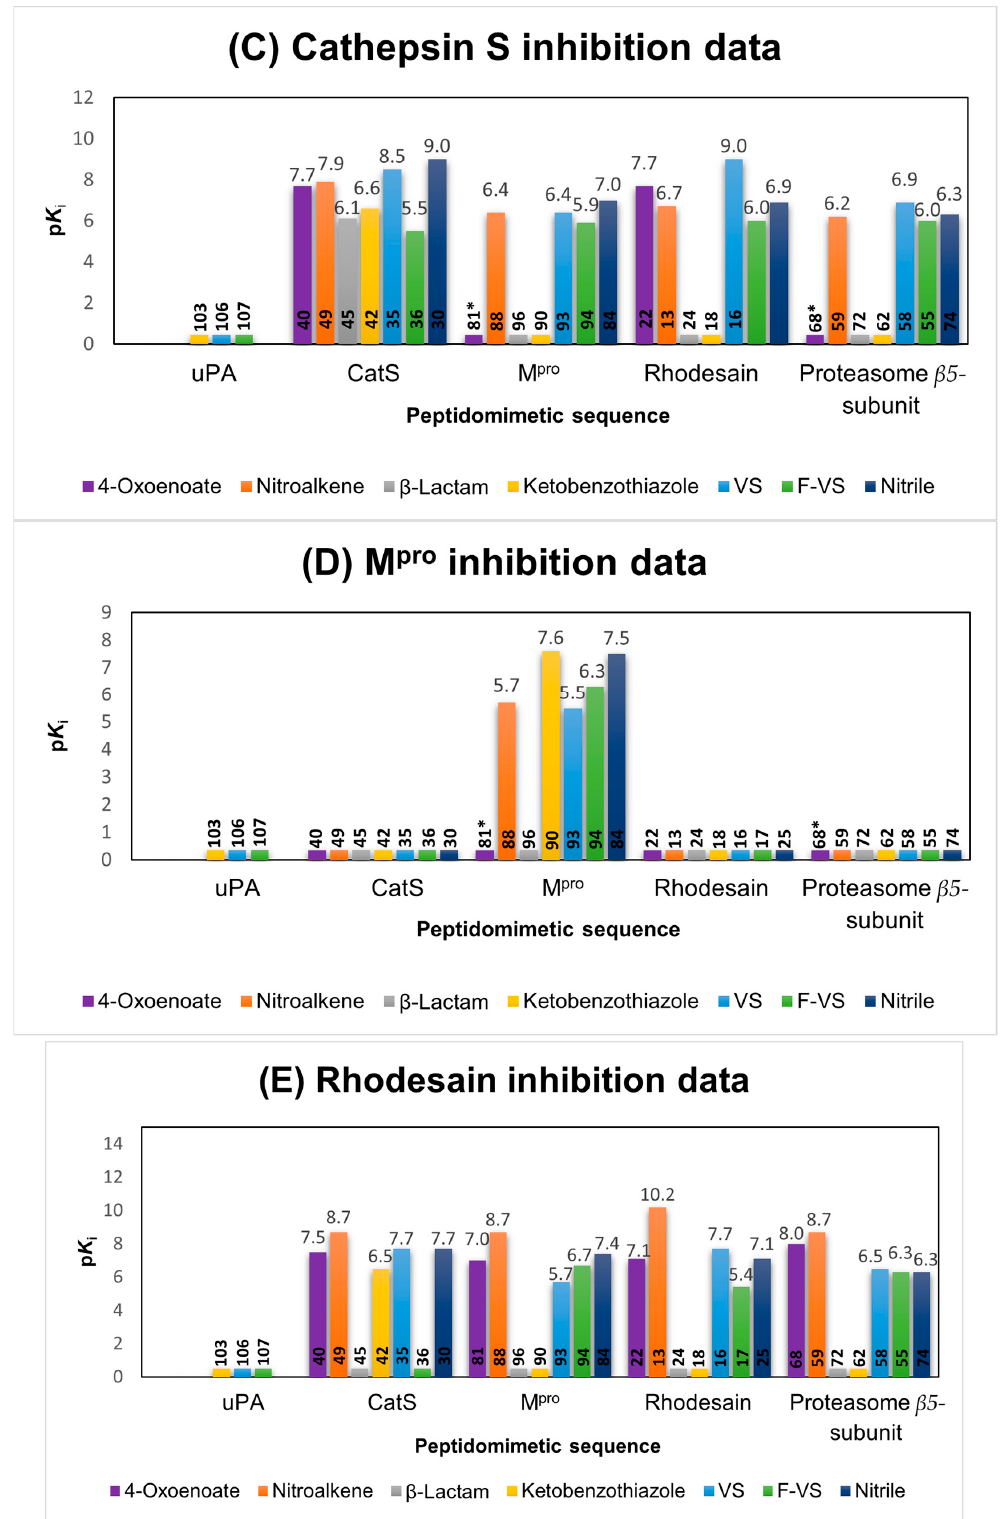
Figure 6. Inhibition data for the assays with uPA ( A ), proteasome β 5-subunit ( B ), cathepsine S ( C ), SARS-CoV-2 M pro ( D ) and rhodesain ( E ). p K i values were calculated from the K i values (–log 10 (K i /M)) [59]. The height of a bar indicates the inhibitory potency of an inhibitor towards the target enzyme, and the color of a bar indicates the warhead of the inhibitor; the peptidomimetic sequence is indicated by the enzyme name under the bars, e.g., the purple bar with the height